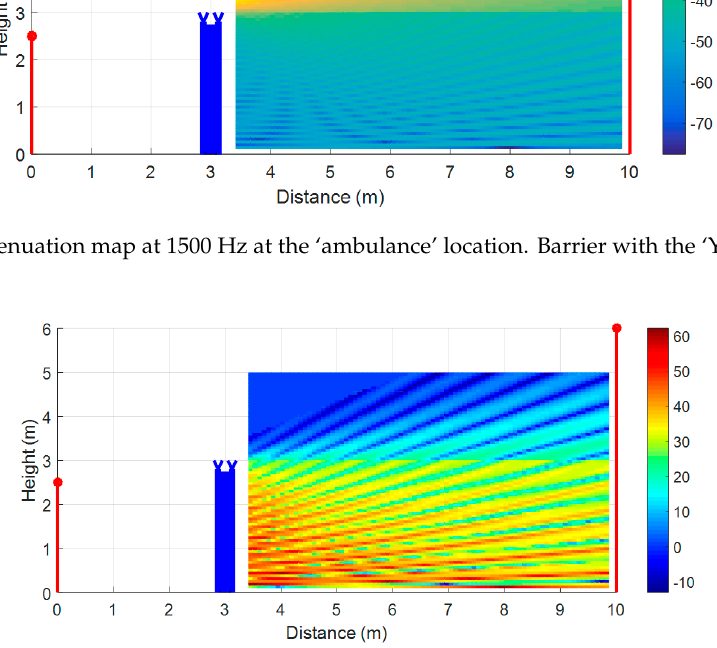
Figure 24. IL map at 1500 Hz at the ‘ambulance’ location. Barrier with ‘the Y–Y’ cap and 3 m height.